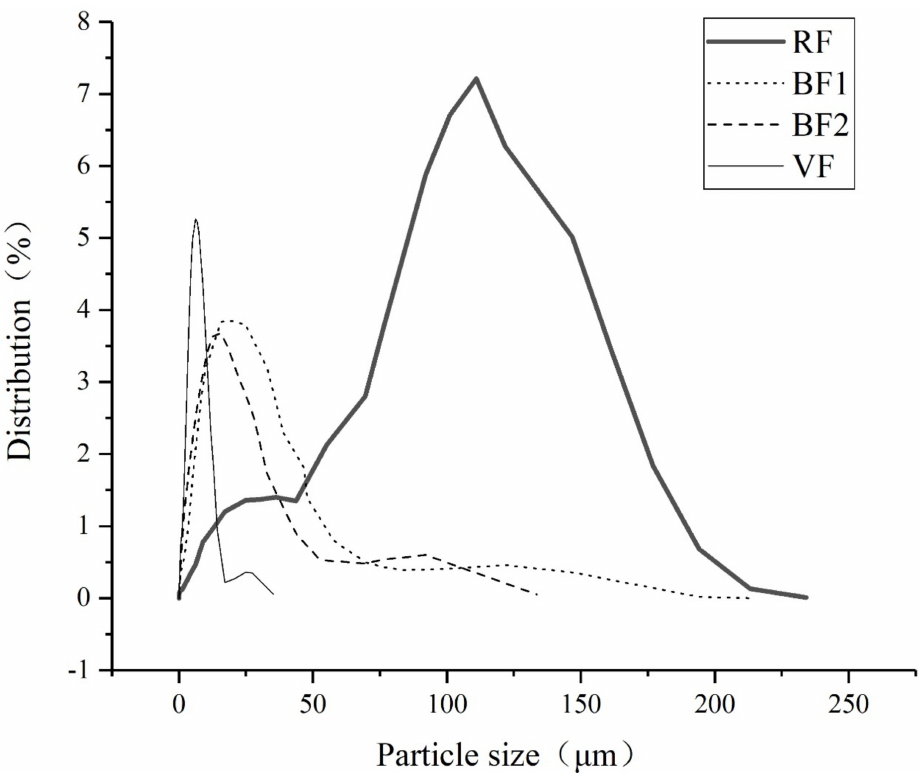
Figure 1. Particle size distribution of different fly